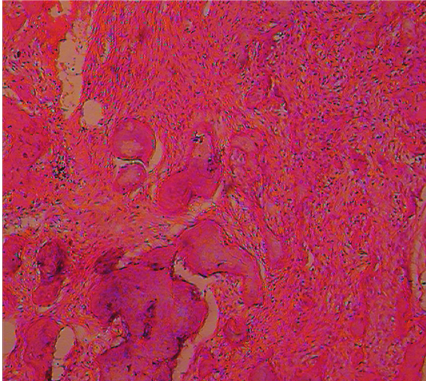
Figure 14: Photomicrograph (10x, H and E stained section) showing features of cemento-ossifying fibroma (Case